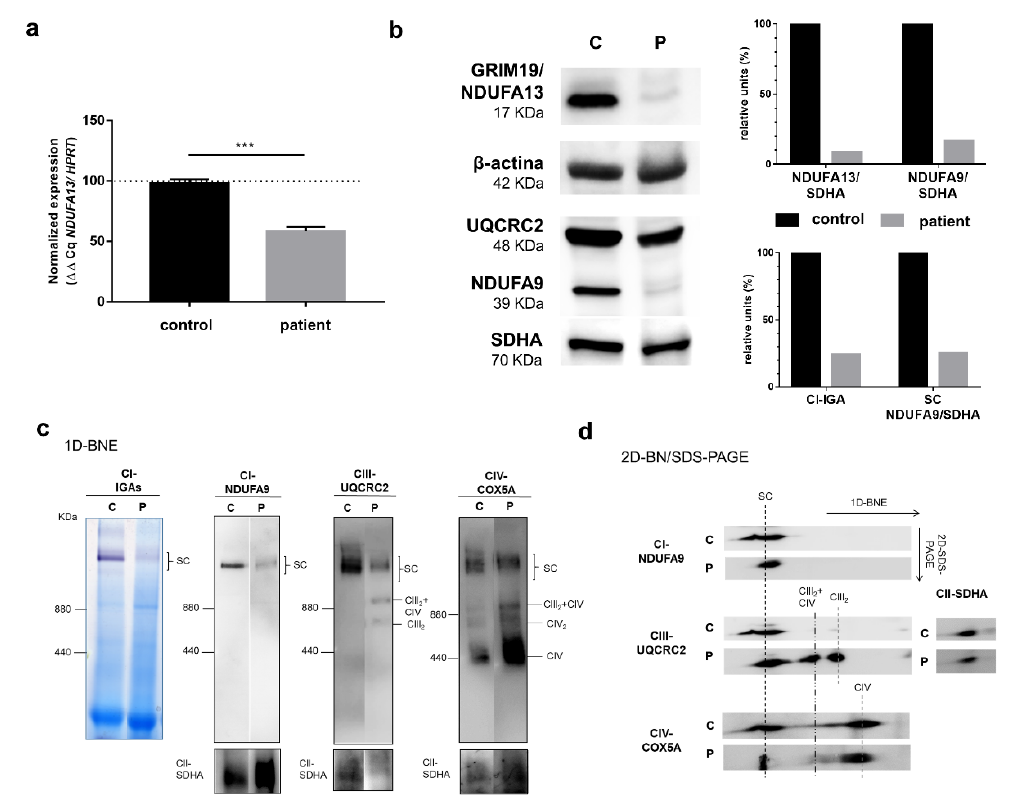
Figure 3. Analyses of NDUFA13 mRNA expression, NDUFA13 protein levels, and structural state of OXPHOS supercomplexes (SC) in cultured skin fibroblasts. Panel ( a ) NDUFA13 mRNA expression levels by quantitative q-RT-PCR on mRNA isolated from cultured skin fibroblasts of a control and the patient. Results were normalized to hypoxanthine phosphoribosyltransferase 1 (HPRT) mRNA levels and expressed as percentage of control; n = 3, error = SD. p-values were calculated by unpaired t-test. *** p < 0.001. Panel ( b ) Western blot showing lower levels of complex I subunits NDUFA13 and NDUFA9, in the patient’s cells compared to the control; upper right diagram, Western blot densitometric values for NDUFA13 and NDUFA9 normalized by SDHA (CII); lower right diagram, densitometric values of CI-IGA and 1D-BNE (CI-NDUFA9) normalized by SDHA (CII). Panel ( c ) Complex I in-gel activity (CI-IGA) assay and one-dimensional blue native electrophoresis (1D-BNE) analysis of digitonin-solubilized mitochondria from control and proband’s fibroblasts showing OXPHOS complexes I to IV (CI–CIV). Complex II (anti-SDHA) was used as a loading control. Ferritin was used as molecular mass standard (on the left of gels): monomer (440 kDa) and dimer (880 kDa); Panel ( d ) 2D-BN / SDS-PAGE analysis of the steady-state levels of respirasome and SC I + III 2 (SC). CIII 2 + CIV, supercomplex containing CIII 2 and CIV. CIII 2 , dimeric CIII. CIV 2 , CIV dimer. C: control, P: patient.